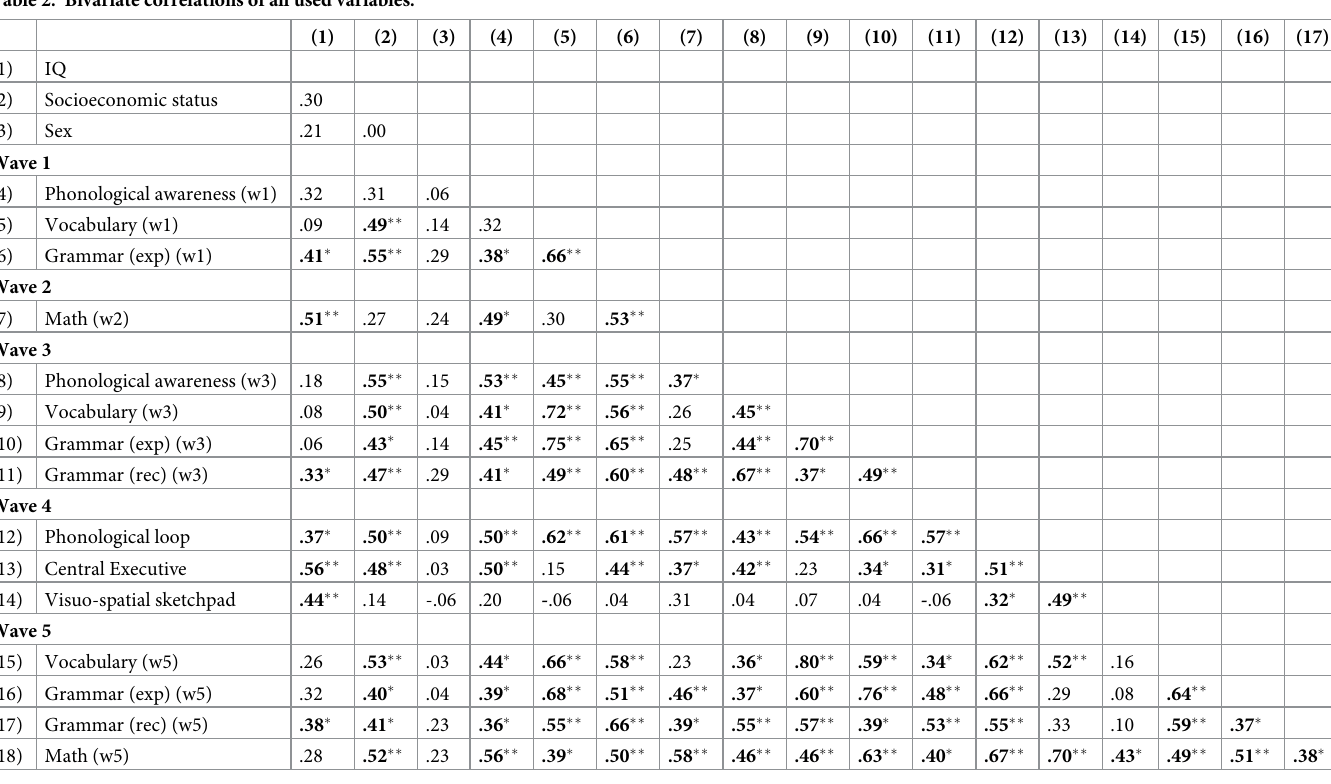
Table 2. Bivariate correlations of all used